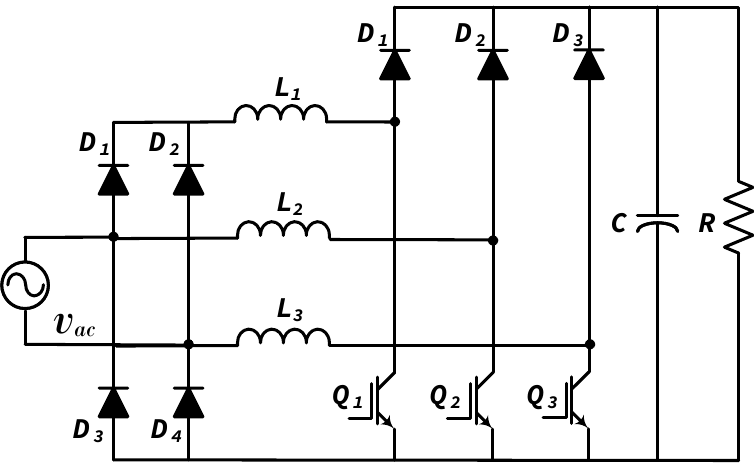
Figure 4. Hybrid Interleaved PFC